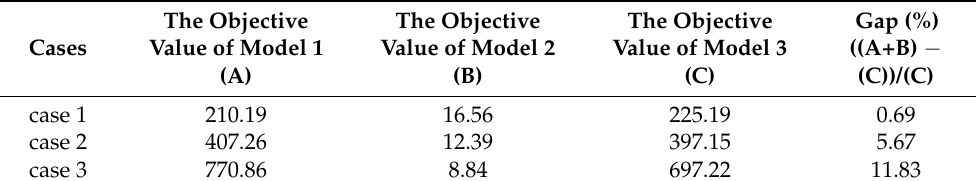
Table 6. The experimental results for the change in the number of transport companies (forwarders).